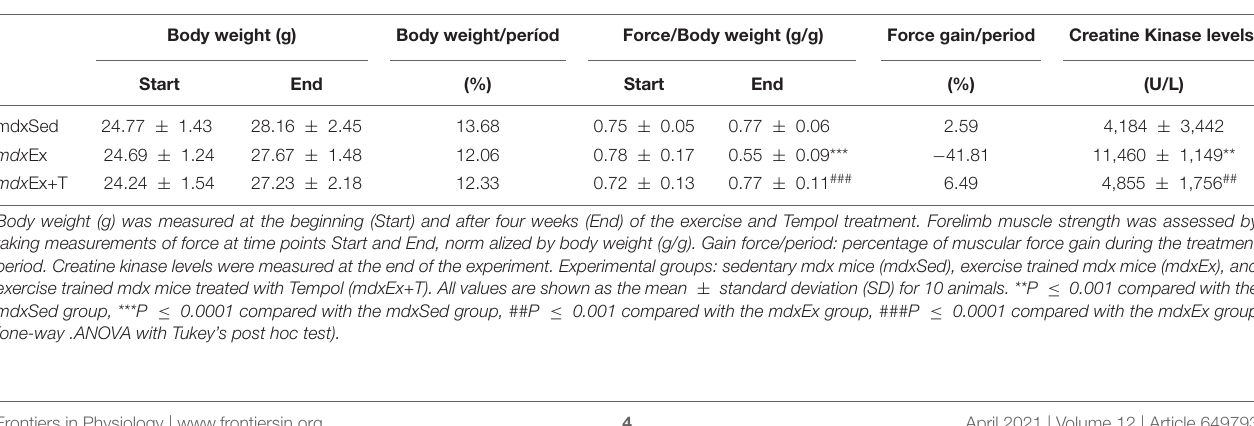
TABLE 1 | Body weights, forelimb muscle strength, and CK